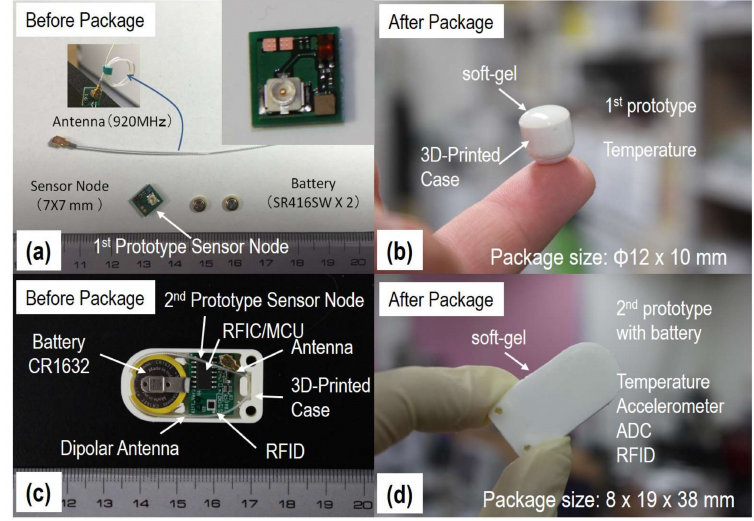
Figure 1. Photos of the first prototype sensor node and second prototype sensor node before ( a , c ) and after packaging ( b , d ) using the 3D-printed case, and then covering and filling with bio-compatible